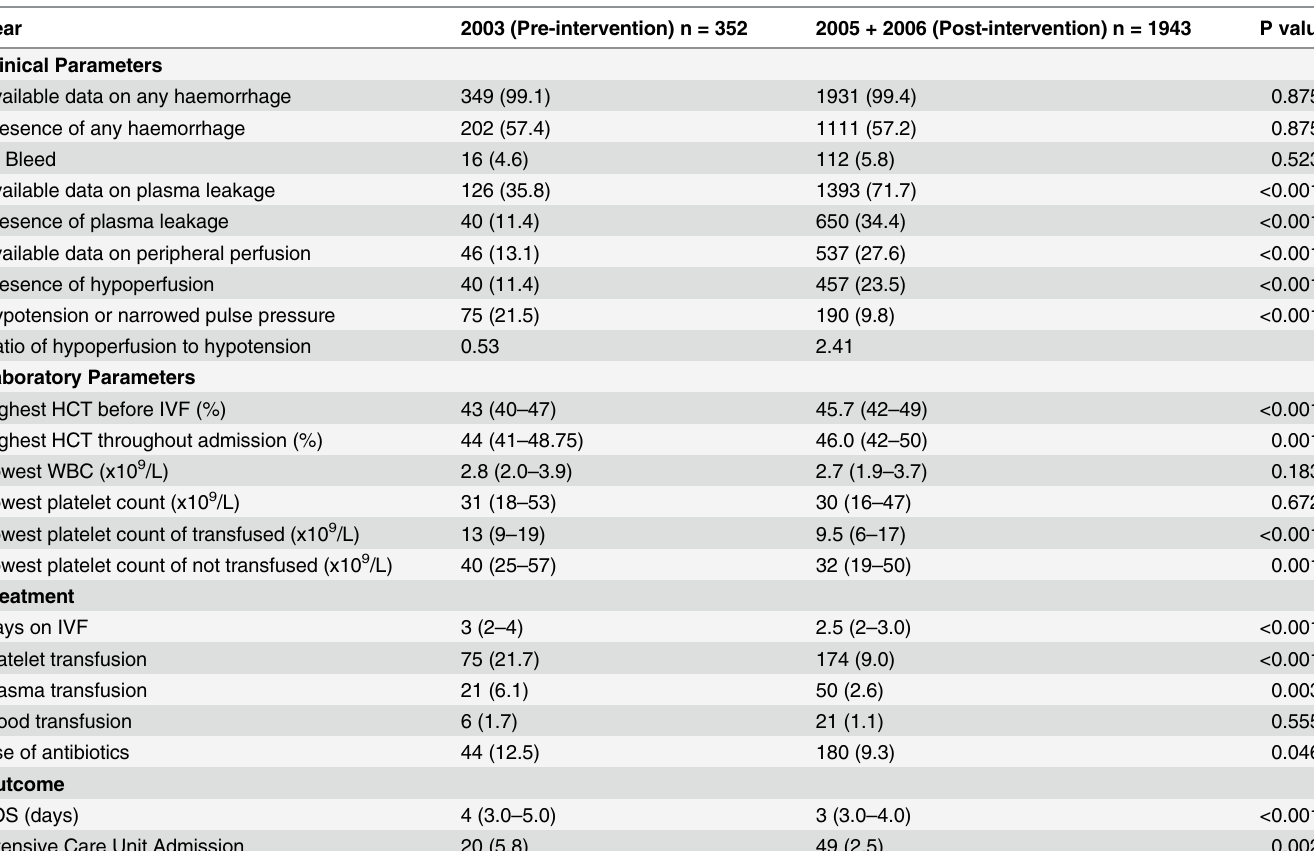
Table 2. Summary of results: Clinical parameters, laboratory parameters, treatment and